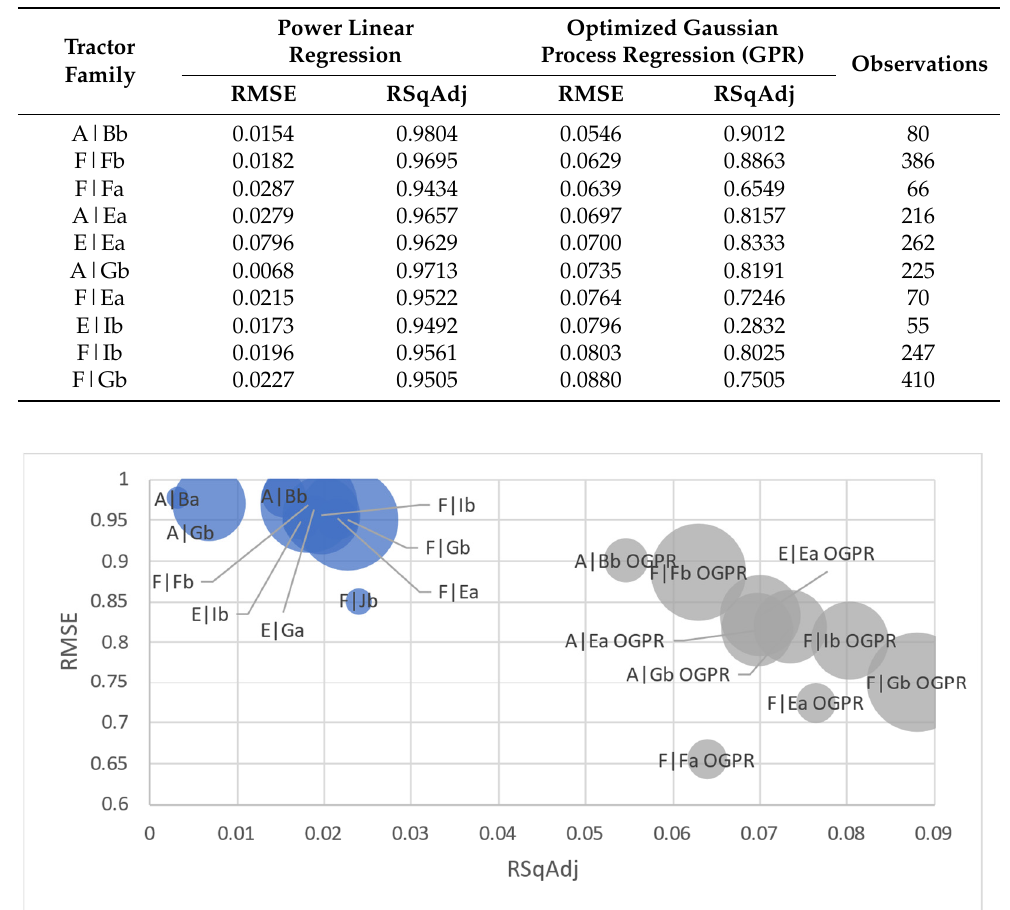
Figure 6. RMSE values for optimized Gaussian process results of two predictors, grouped by families tested (bubble size represents number of observations). Table 11. Regression results for tractor families using two predictors.